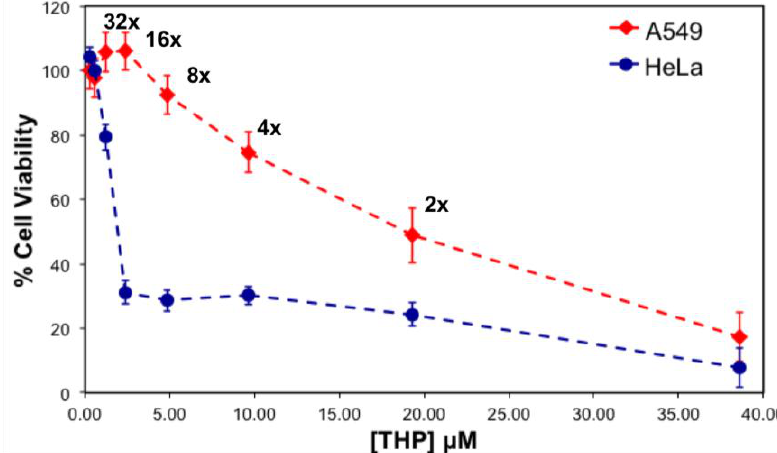
Figure 10. Viability of A549, HeLa cells treated with serially diluted complexes at 5:1 EAR8-II to THP complex for 24